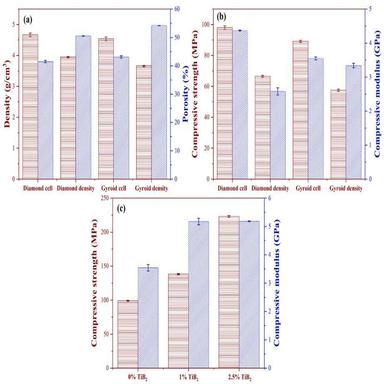
(a) Porosity and density of the four interconnected pore-gradient TPMS structures; (b) the compressive strength and modulus of the four pore-gradient structures made of plain stainless-steel, and (c) compressive strength and modulus of nanocomposite interconnected pore-gradient structures doped with different volume fractions of TiB2 nanoparticles.